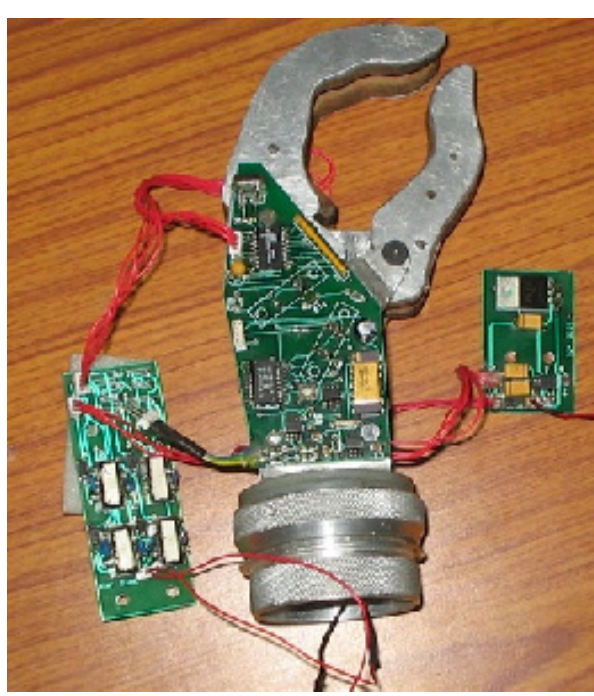
Fig. 5. Below-elbow myoelectric